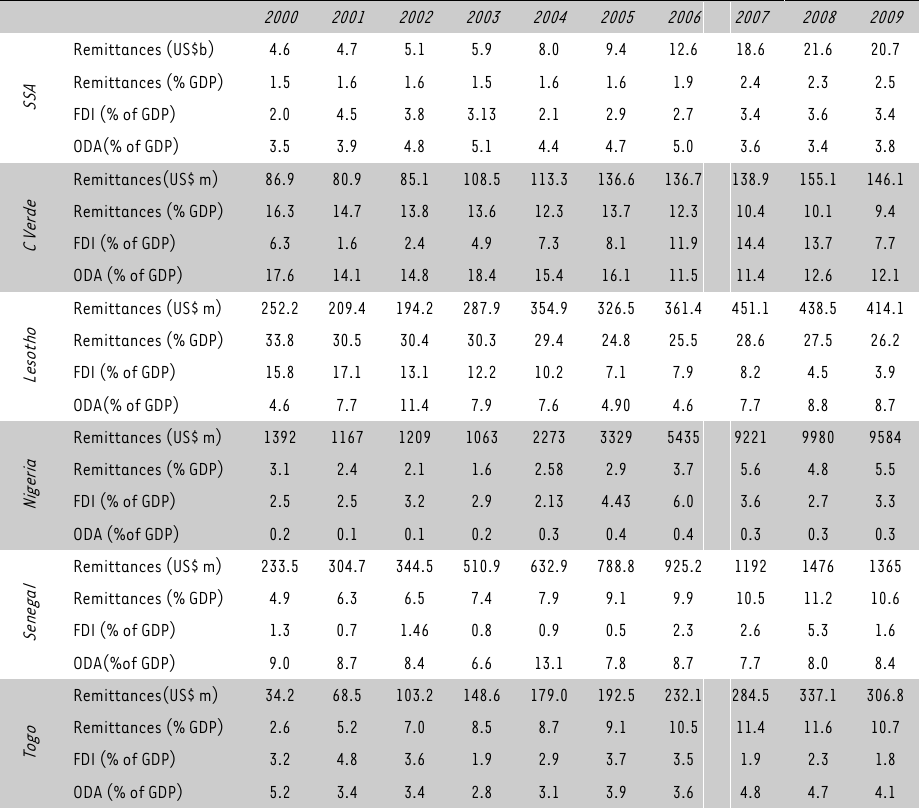
Trend of Remittances, and other Resource Flows to Sub-Saharan Africa: 2000 - 2009 2000